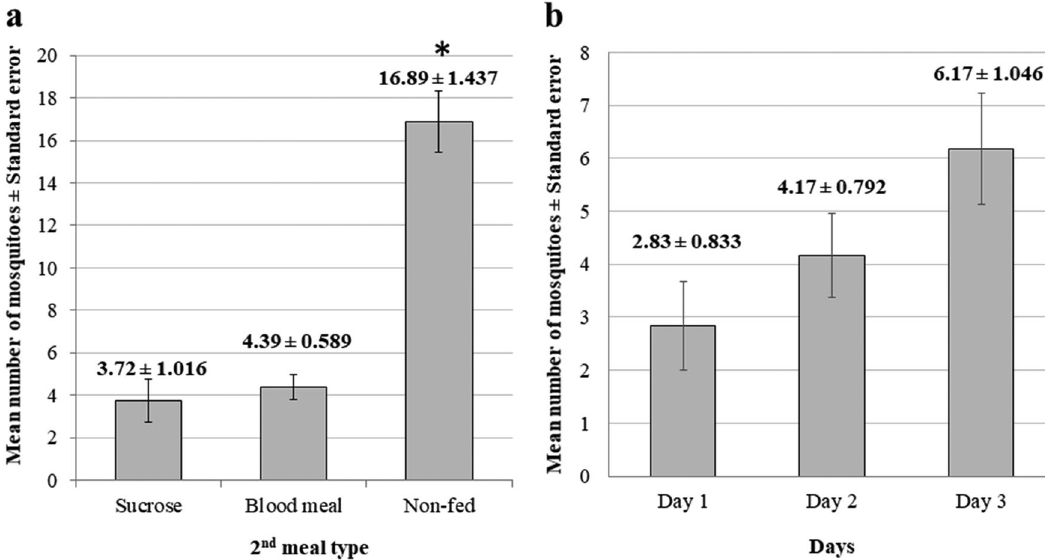
Figure 2. ( a ) The mean number (± standard error) of mosquitoes according to their second meal preference after initial human blood feeding within a single gonotrophic cycle. ( b ) The mean number (± standard error) of mosquitoes preferring second blood meal according to the number of days post-fed with human blood